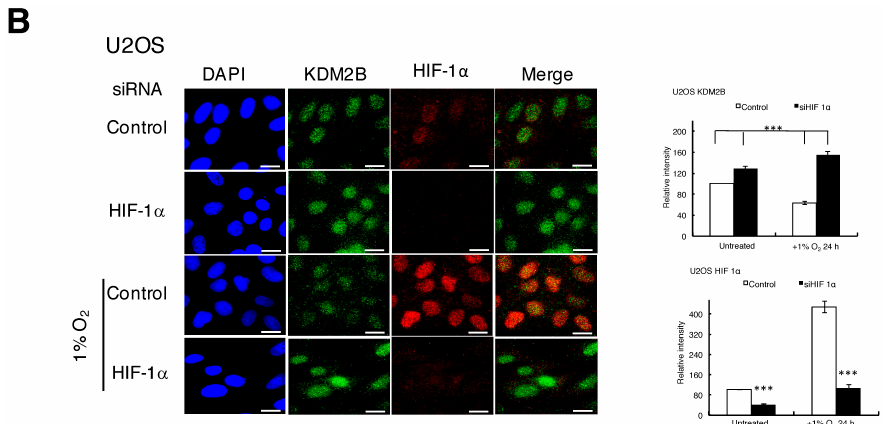
Figure 3. Hypoxia-induced KDM2A protein requires HIF- α /HIF-1 β heterodimer. ( A ) U2OS and HeLa cells were transfected with the indicated siRNA oligonucleotides for 48 h prior to lysis. Where indicated, cells were also exposed to 1% O 2 , for 24 h, prior to lysis. Cell lysates were analysed by Western blot using the indicated antibodies. ( B ) U2OS cells were grown on cover slips and transfected with the indicated siRNA oligonucleotides prior to methanol fixation. Where indicated, cells were also exposed to 1% O 2 , for the periods of time depicted, prior to fixation. Cells were stained with anti-KDM2B, HIF-1 α antibodies, and DAPI to mark chromatin. Scale bar represents 10 µm. Images were acquired using a Deltavision microscope, and deconvolved and analysed using Omero software. Pixel intensities were quantified in Omero using the ROI tool. Graph depicts mean and standard deviation (SD) of a minimum of 100 cells per condition. Student t-test was performed and p values calculated. *** p < 0.001.